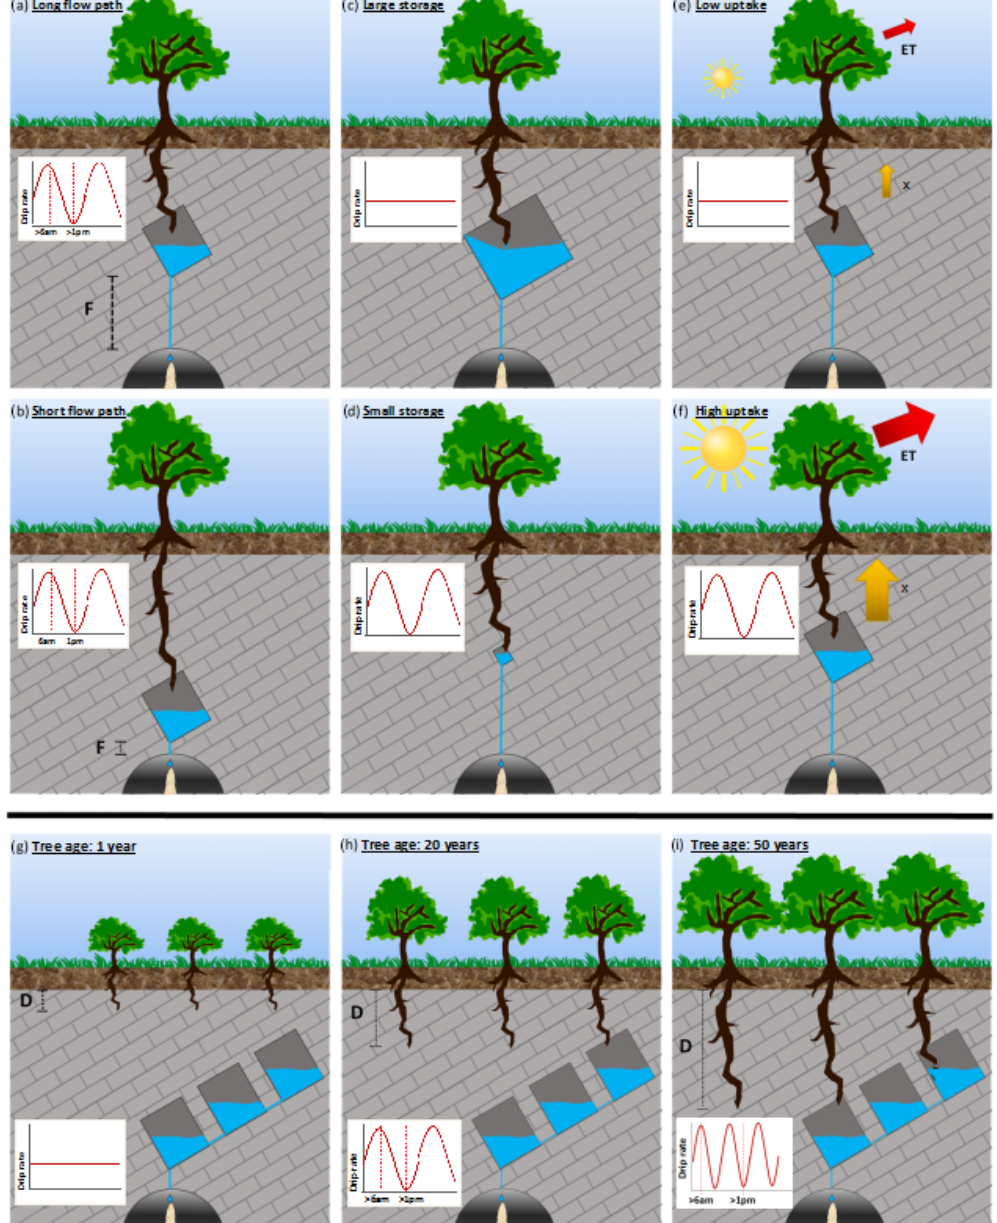
Figure 7. A conceptual representation of tree water use from karst stores under different circumstances. (a) and (b) show different karst store-drip site flow path lengths ( F ) as the tree roots access karst stores at different depths; (c) and (d) show tree roots accessing karst stores with different volumes; the influence of annual insolation on evapotranspiration (ET) and root water uptake ( x ) during winter and summer is shown in (e) and (f) , respectively. Finally, the increase in rooting depth ( D ) and access to deeper karst stores over time in years is explored in (g) – (i)